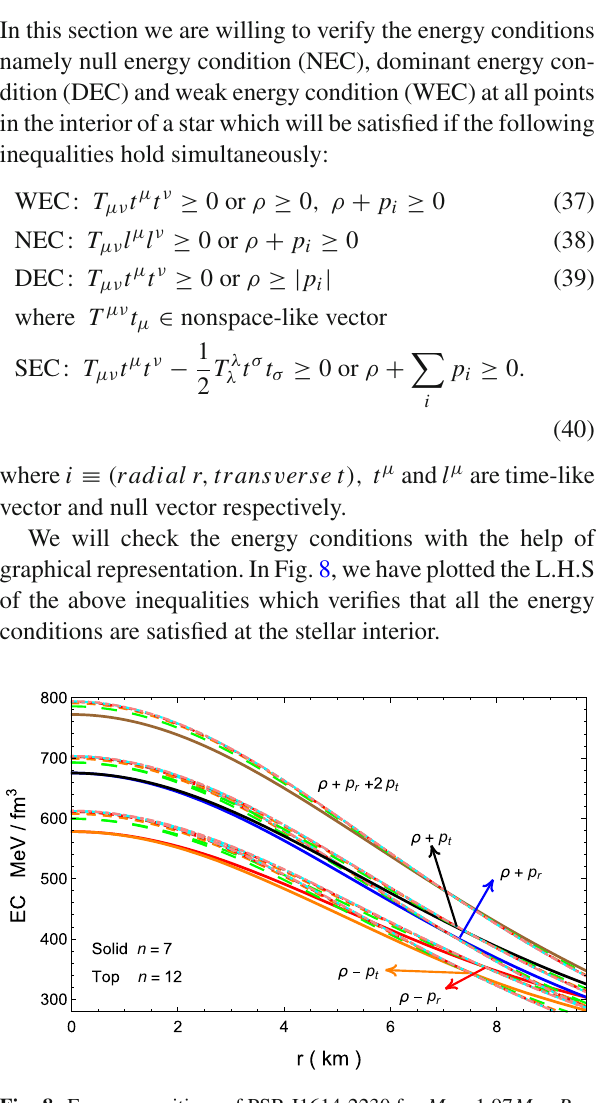
Fig. 8 Energy consitions of PSR J1614-2230 for M = 1 . 97 M (cid:6) , R = 9 . 69 km and b = 0 .